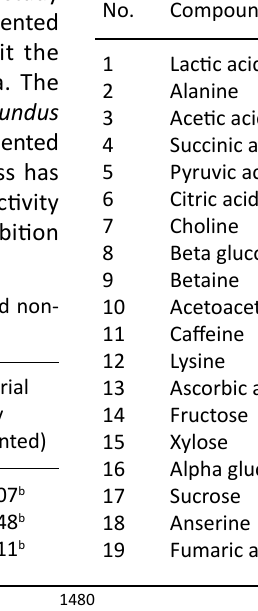
Table 2. Assignments of 1 H-NMR spectral signals attained from the fermented Cyperus rotundus extract No. Compound Chemical